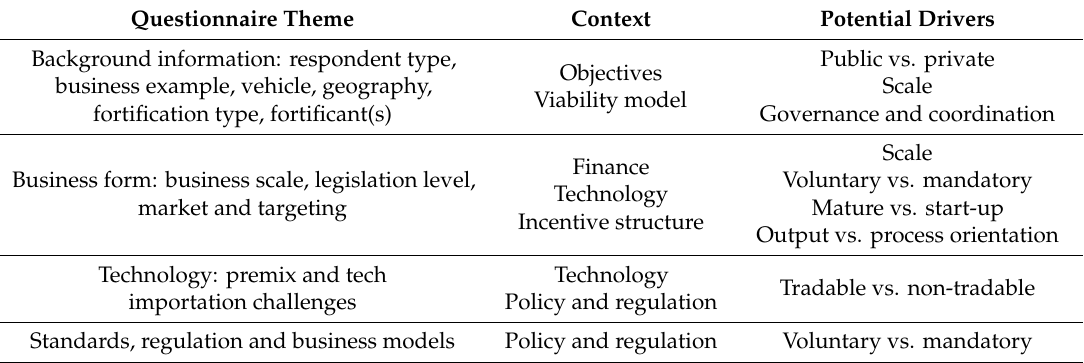
Table 1. The relationship between business context, hypothesised drivers of business success and failure, and fortification business